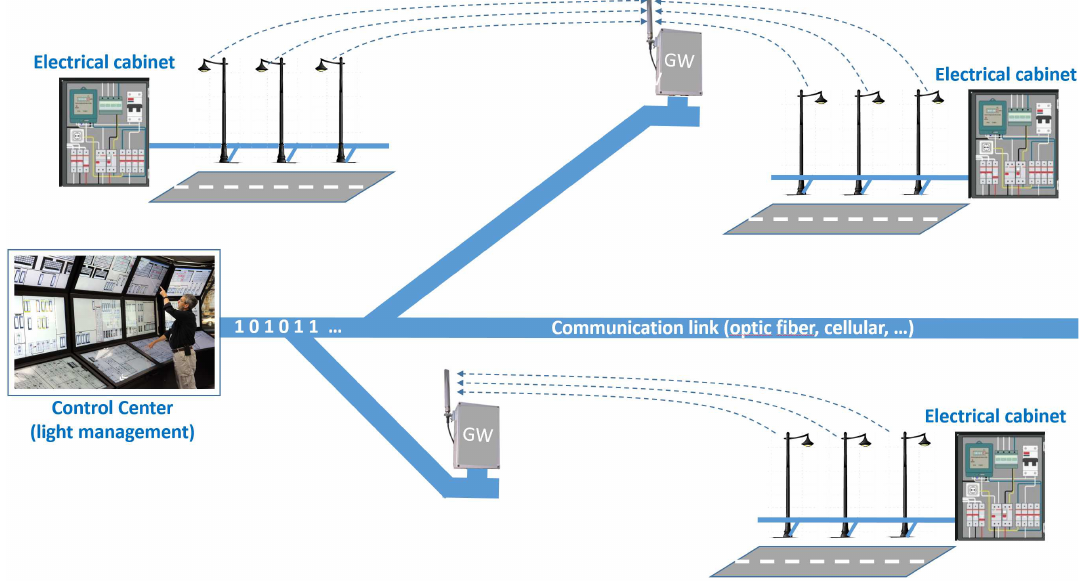
Figure 3. LoRaWAN/Sigfox-based smart lighting